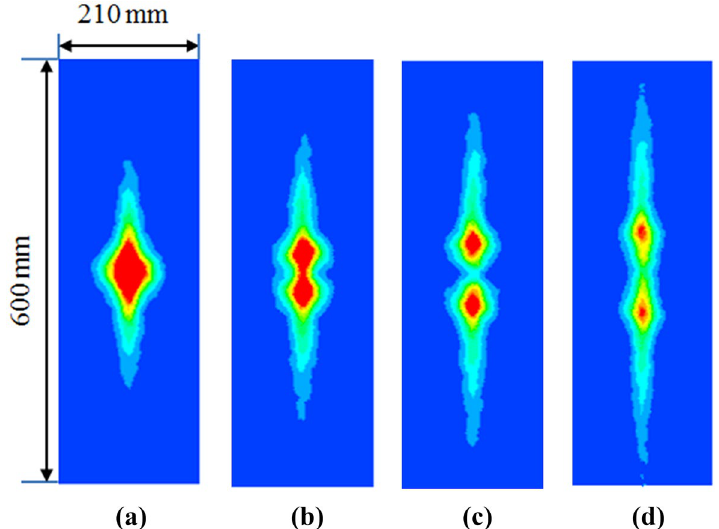
Fig. 6 Coating thickness contours for different θ